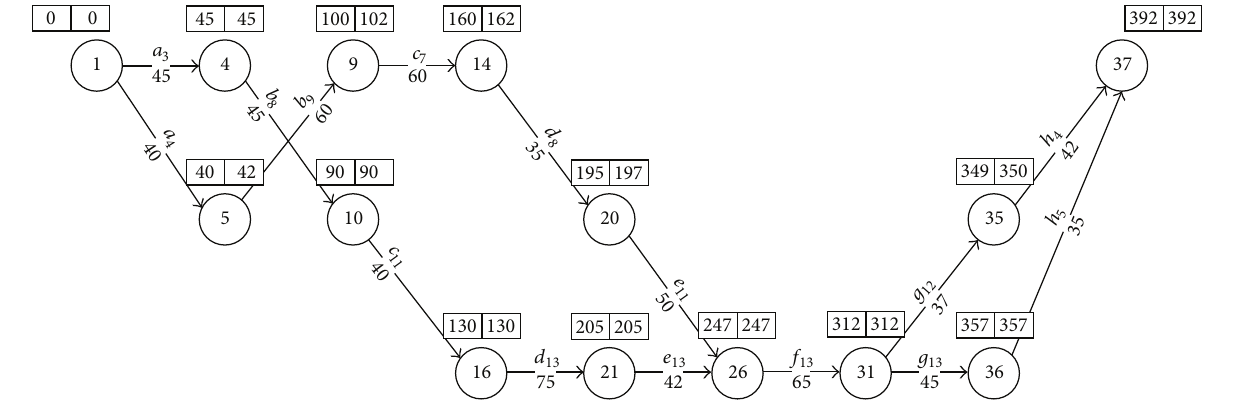
Figure 7: Network with nonredundant activities.